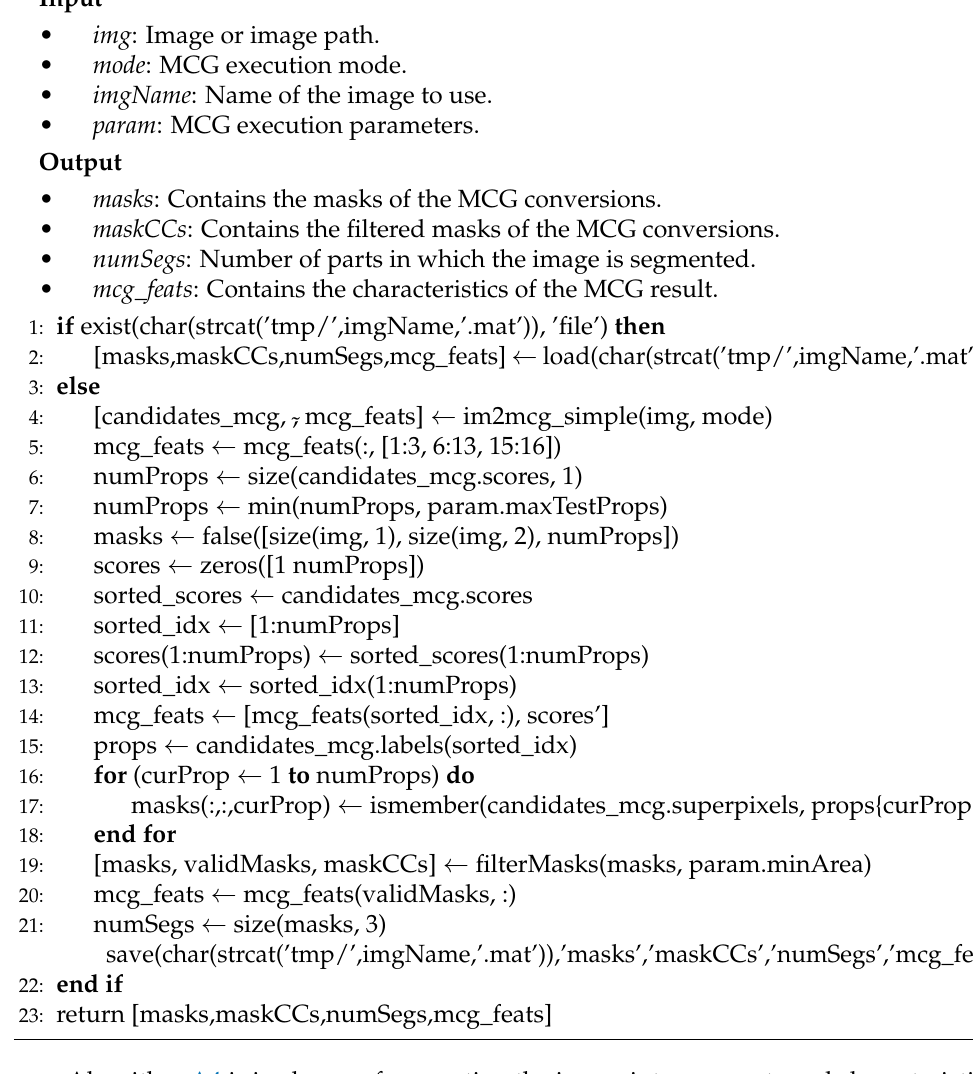
Algorithm A4 is in charge of converting the image into segments and